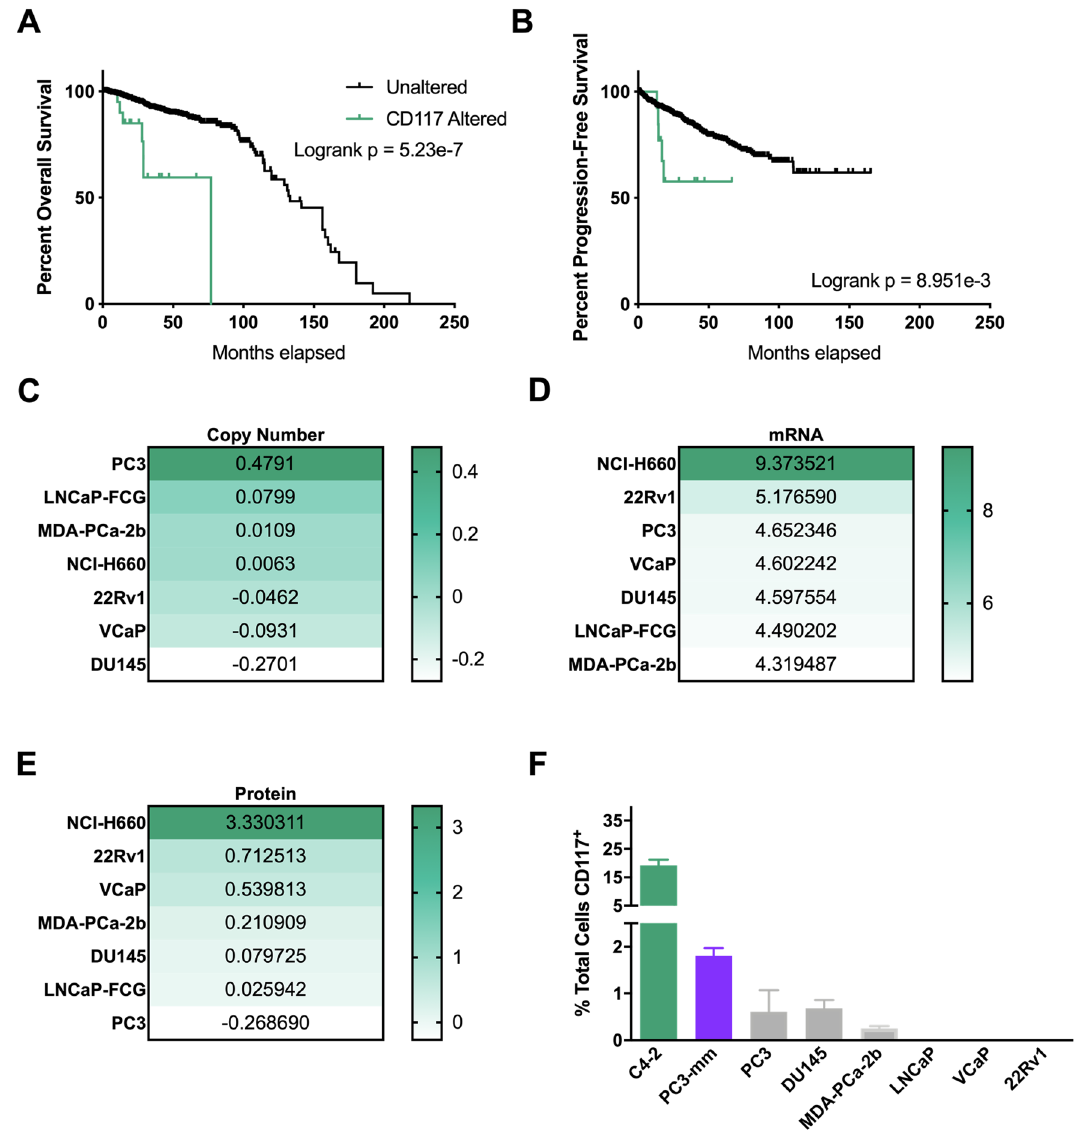
Figure 1. CD117 expression is associated with worse survival and is found in prostate cancer cell lines. ( A , B ) Overall survival ( n = 1476 patients) and progression-free survival ( n = 1,329 patients) percentages with or without CD117 alteration were obtained from The Cancer Genome Atlas via cBioPortal. ( C – E ) Copy number ( C ), mRNA expression ( D ), and protein expression ( E ) values for CD117 in several prostate cancer cell lines were obtained from the Broad Institute Cancer Cell Line Encyclopedia. ( F ) The percentages of CD117+ cells were measured by flow cytometry for C4-2, PC3-mm, PC-3, DU145, LNCaP prostate cancer cell lines and represented as mean ± SEM ( n =